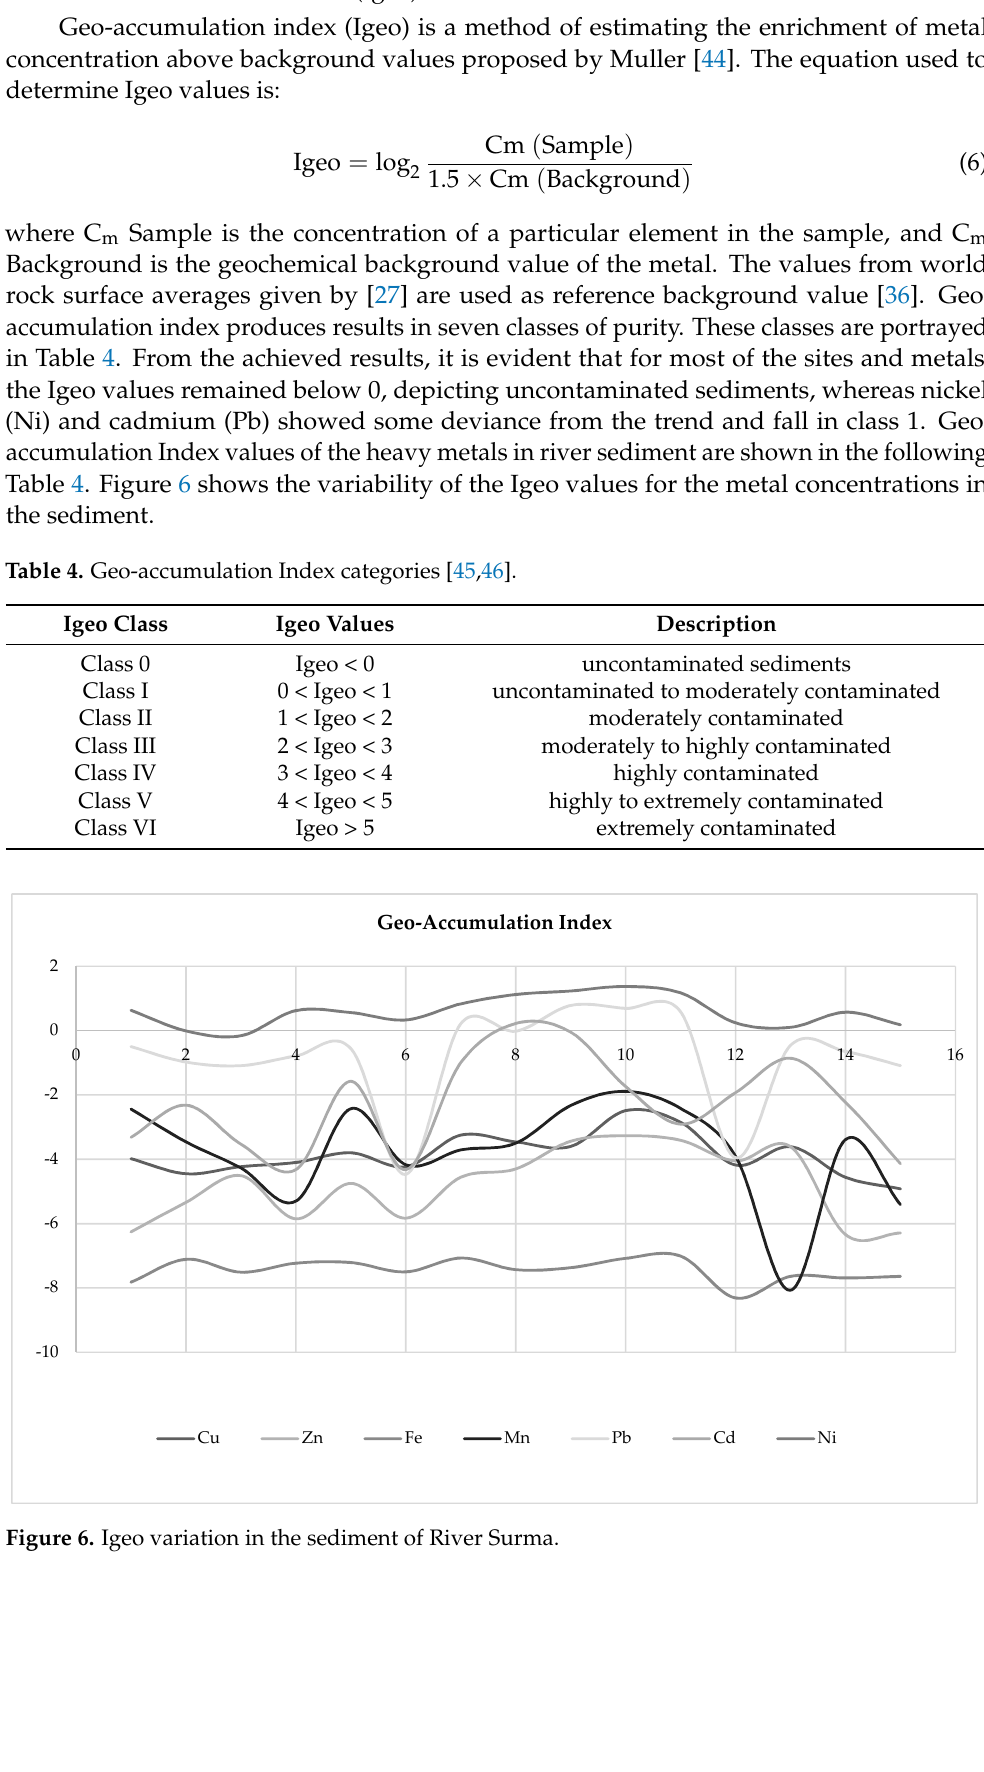
Table 5. Pearson’s Correlation Matrix of heavy metals .